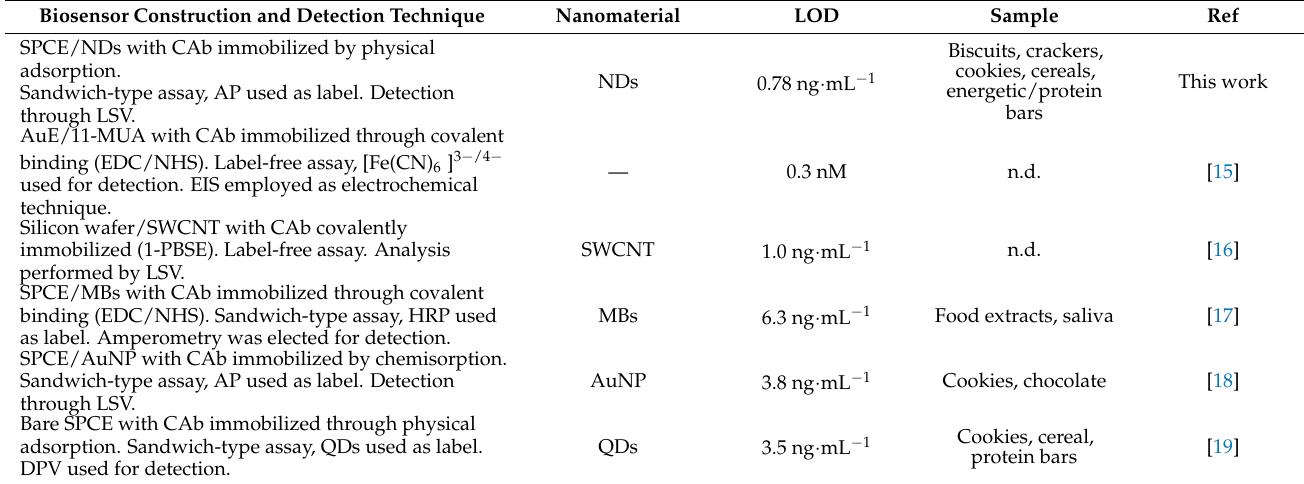
Table 3. Comparison of electrochemical immunosensors for Ara h 1